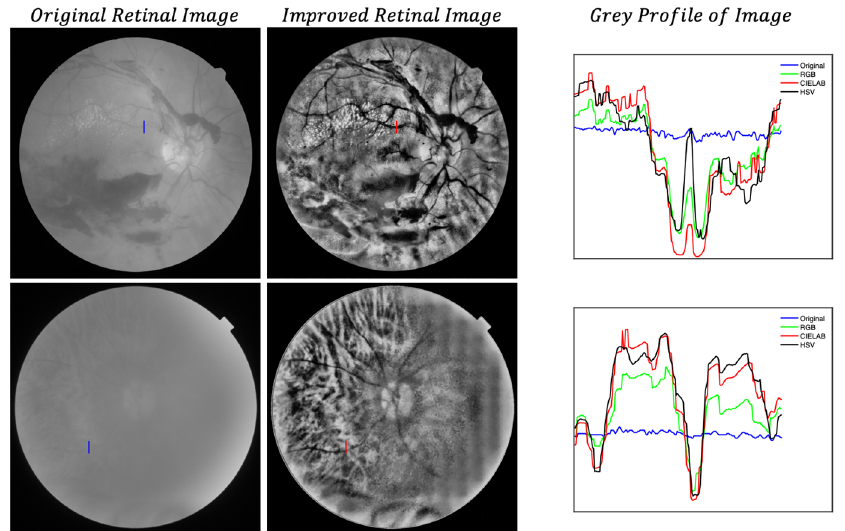
Figure 11. Grey profiles along vertical lines drawn in the images. Grade I cataract (upper row) and grade IV cataract (lower row). BW original image (left column); BW improved CIELAB image (central column); grey profiles in arbitrary units (right column).